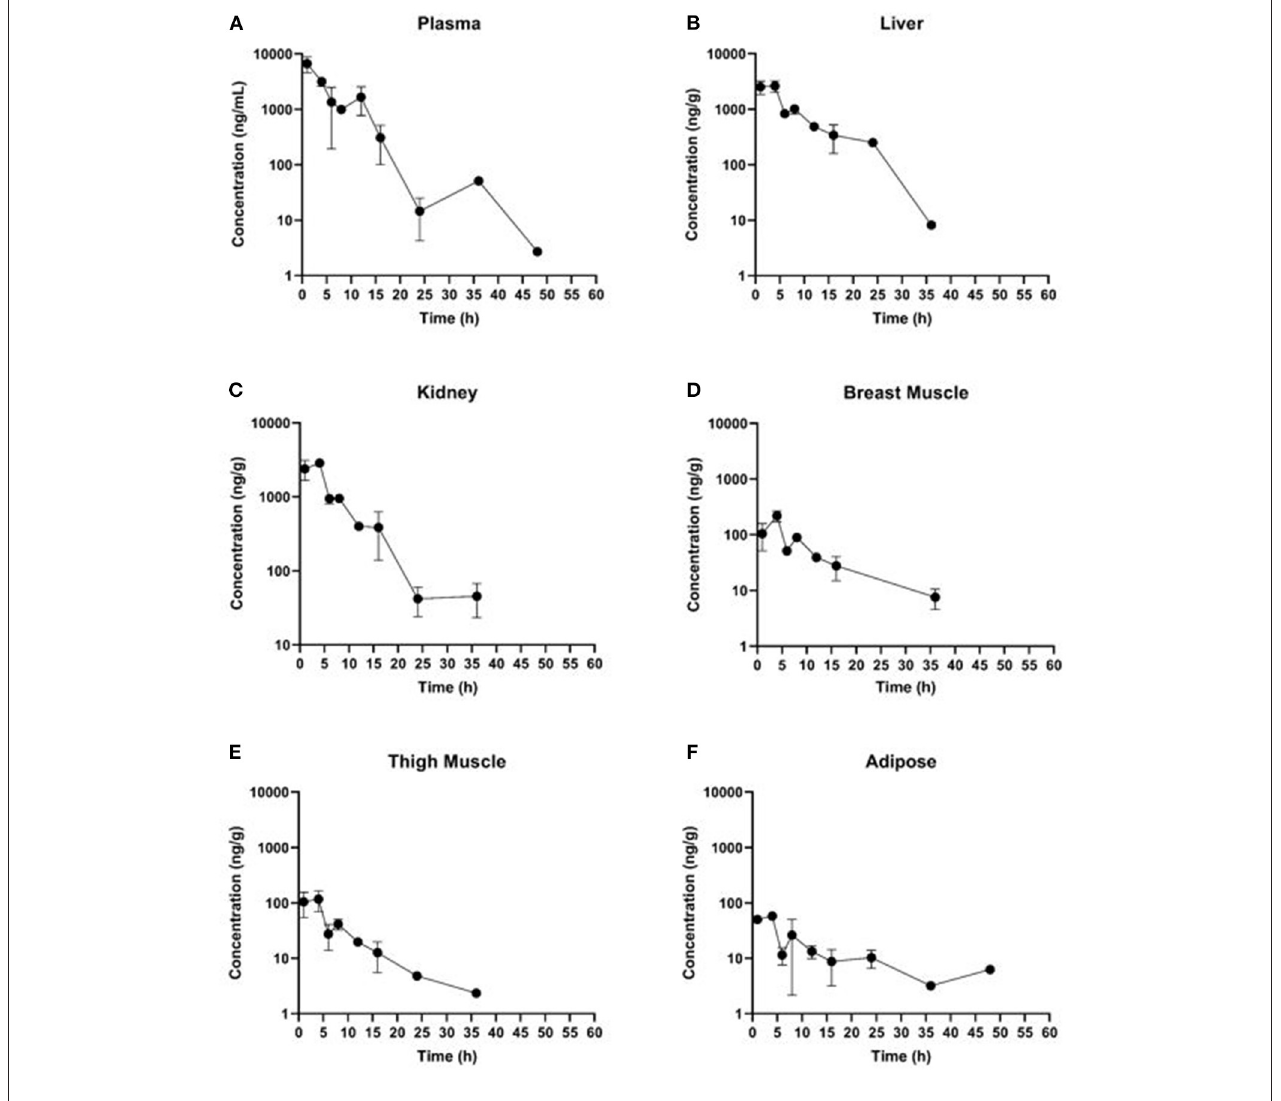
FIGURE 4 | Concentration vs. time curves for tissues collected at slaughter during the PO twice daily dosing regimen group: (A) plasma, (B) liver, (C) kidney, (D) breast muscle, (E) thigh muscle, and (F)